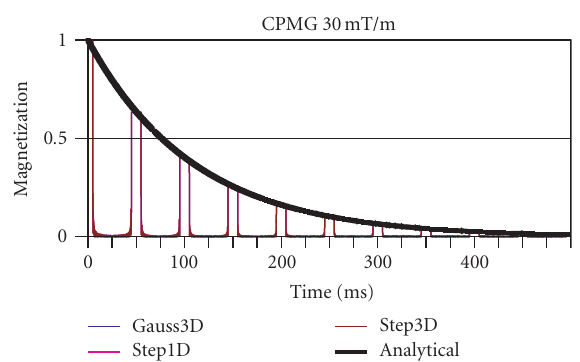
Figure 3: The analytical versus the computed decay curve of the transverse magnetization shown for a CPMG set of parameters.